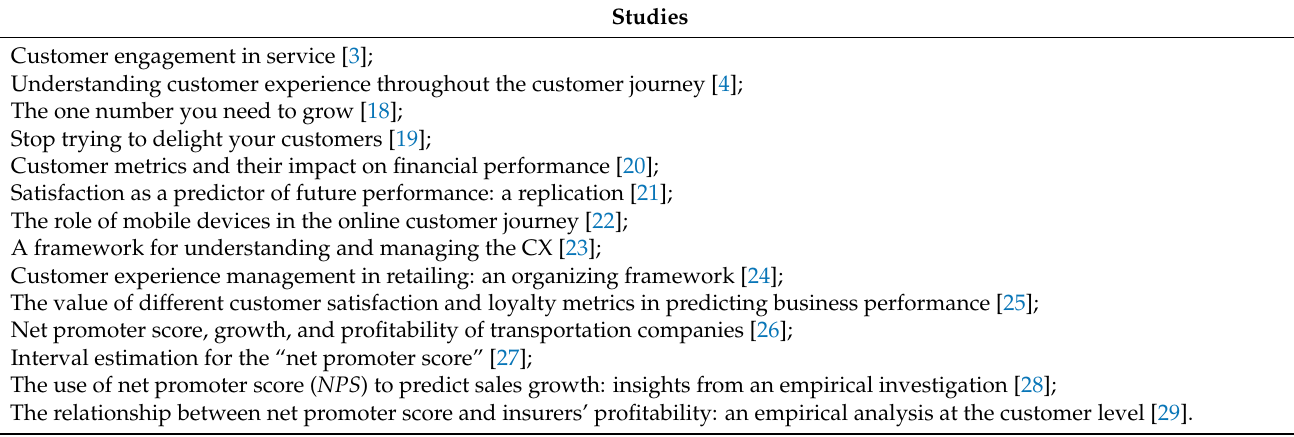
Table 1. Customer Services